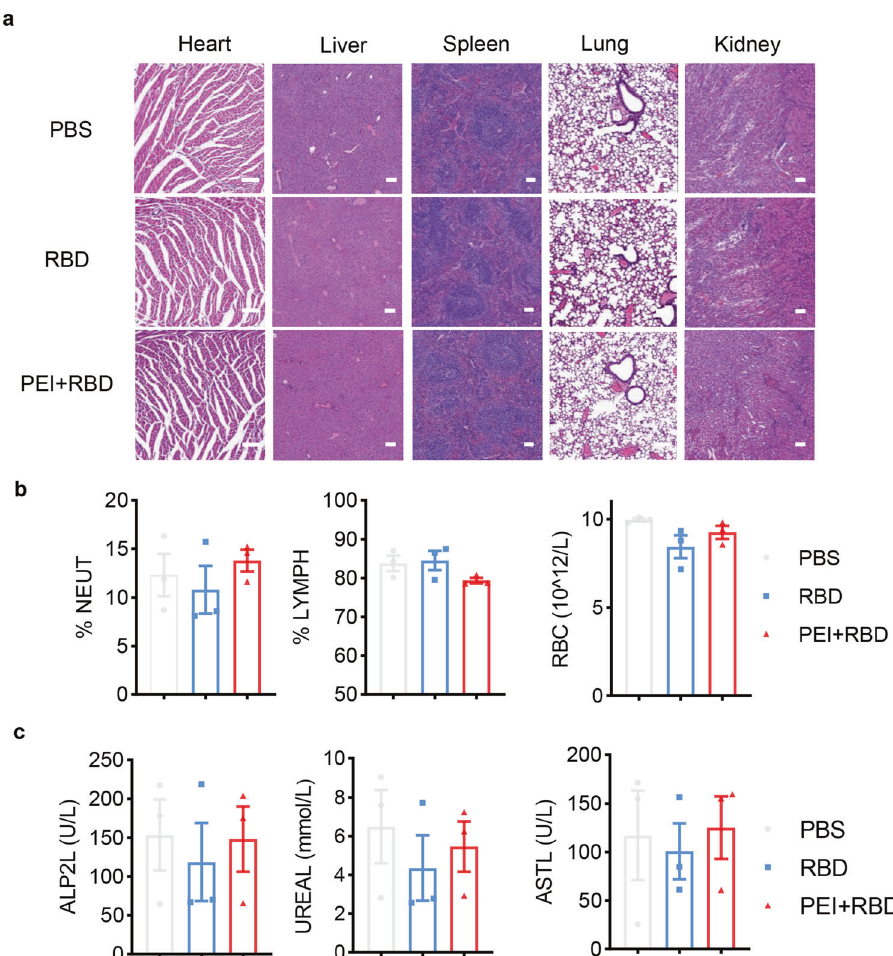
Fig. 8 Long-term safety assessment of the adjuvanted intranasal RBD vaccine in mice. a H&E staining of vital organs from NIH mice immunized with PBS, RBD or PEI + RBD. Blood samples were obtained on day 365 and the peripheral blood cell counts ( b ), biochemical indexes ( c ) were examined. Scale bar, 100 μ